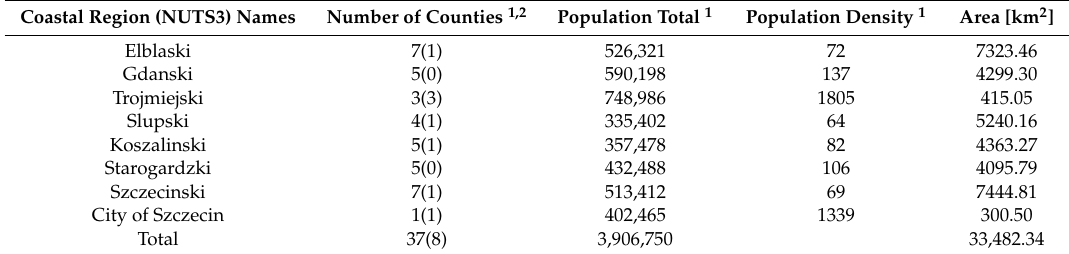
Table 1. Polish coastal regions: area and population.